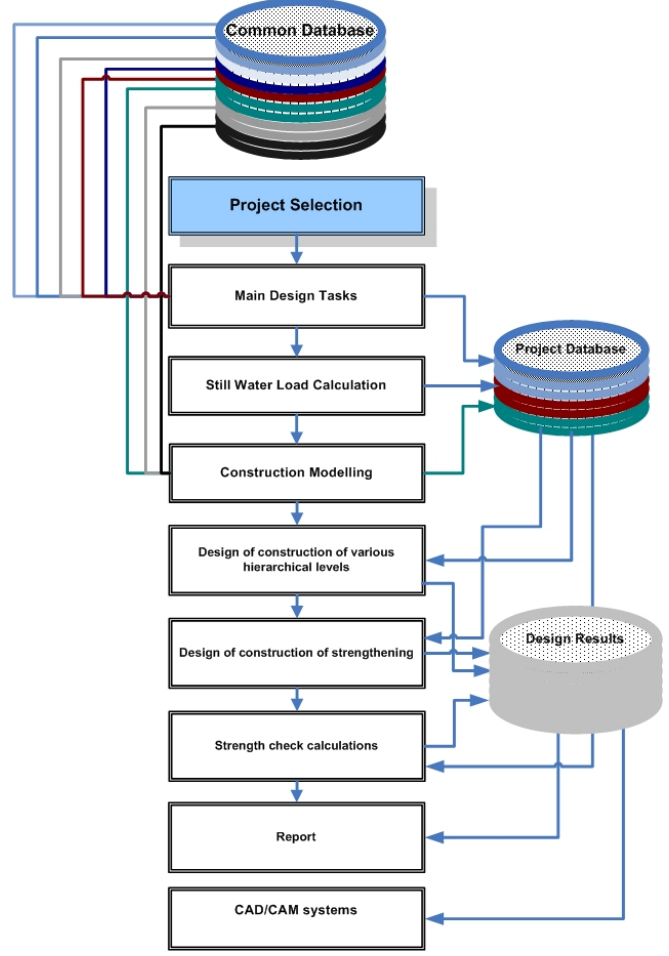
Figure 1. General structure of parametric computer-aided design system.